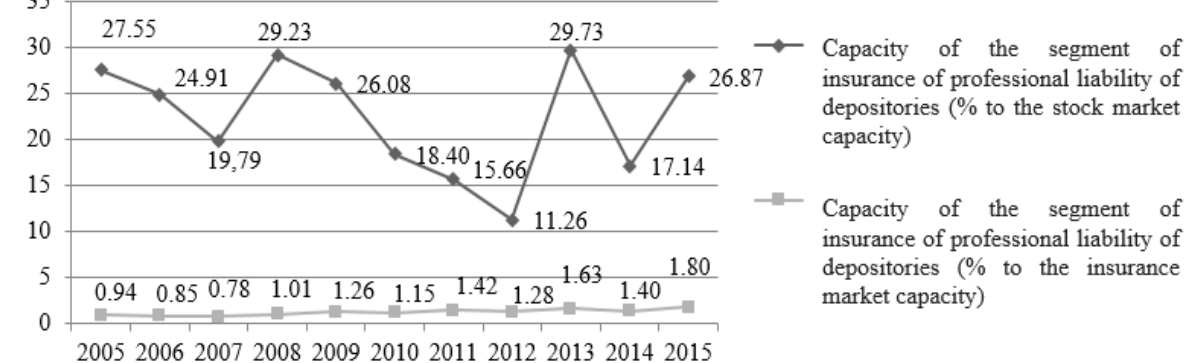
Fig. 5. The ratio of capacity of insurance of depositories’ professional liability to the capacity of the stock and insurance markets